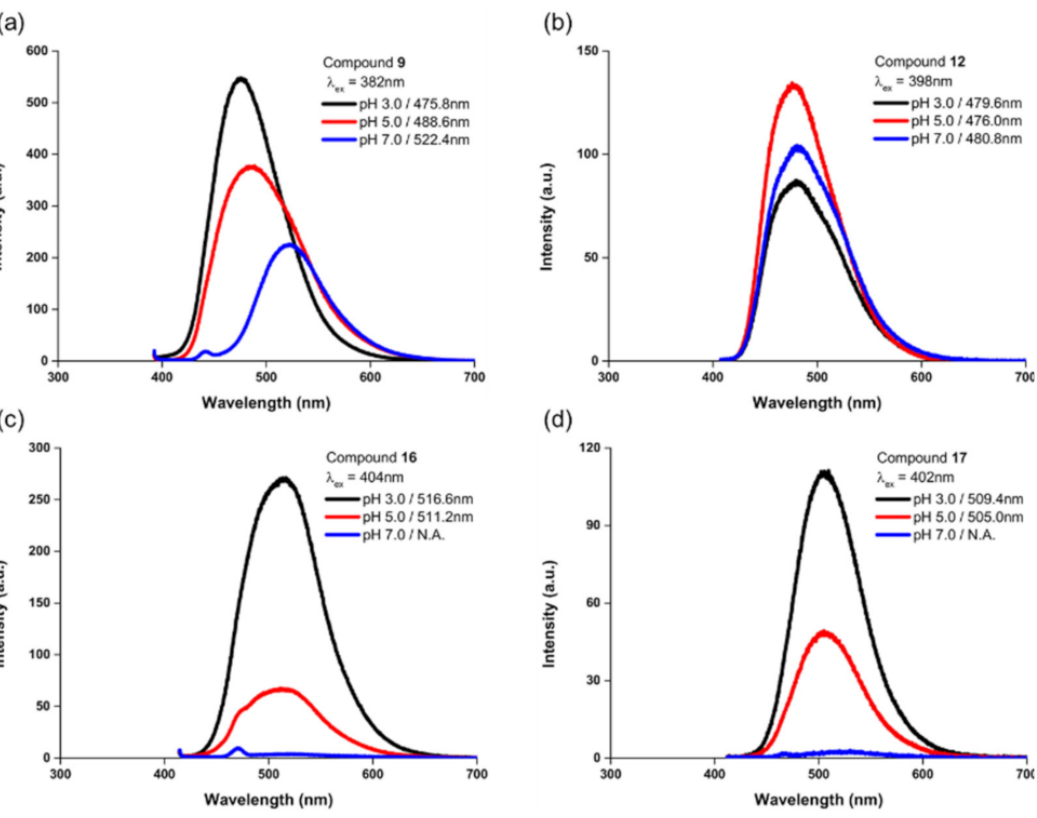
Figure 6. pH response of compound 9 ( a ), compound 12 ( b ), compound 16 ( c ) and compound 17 ( d ). Emission spectra of compounds at different pH buffer solution (3.0, 5.0, and